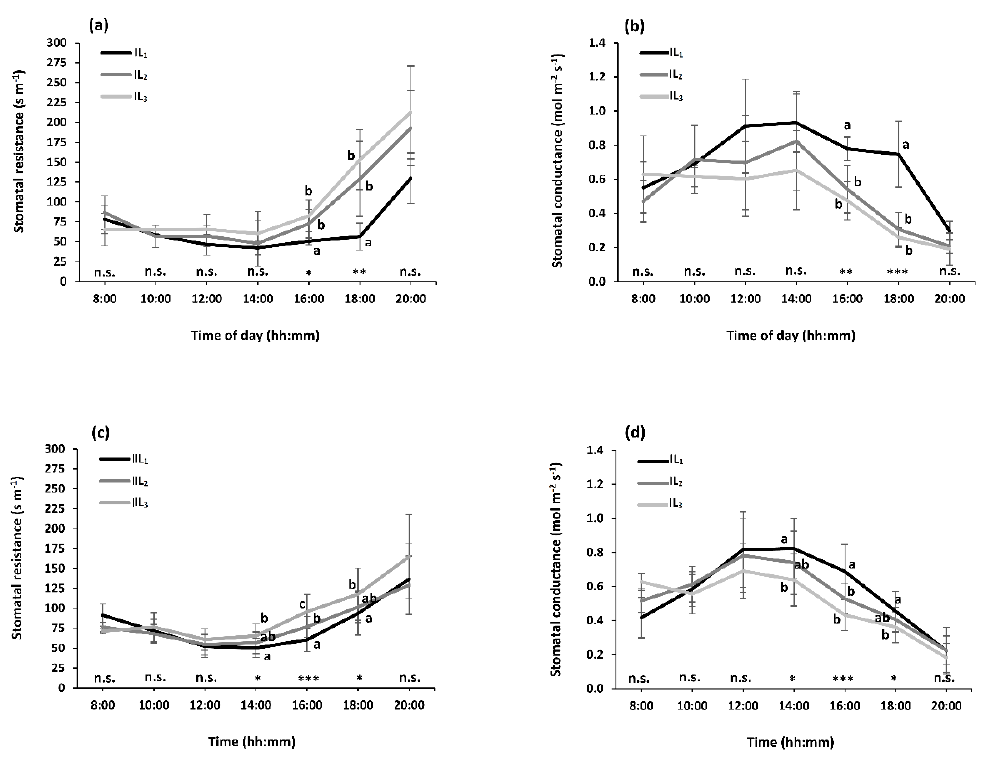
Figure 4. Representative average daytime values of stomatal resistance ( r st ) and stomatal conductance ( g s ) during the phenological stage inflorescence emergence–development of fruit (IF-DF) and maximum water atmospheric demand for the three different irrigation levels. DOY 35 to 45 for the 2018/2019 season ( a , b ) and DOY 3 to 20 for the 2019/2020 season ( c , d ). Error bars indicate ± SE ( n = 5). AVOVA (n.s.: not significance when p > 0.05; * p ≤ 0.05; ** p ≤ 0.01; *** p ≤ 0.001). According to the Tukey test HSD, the means in the same column with the same letter are not significantly different